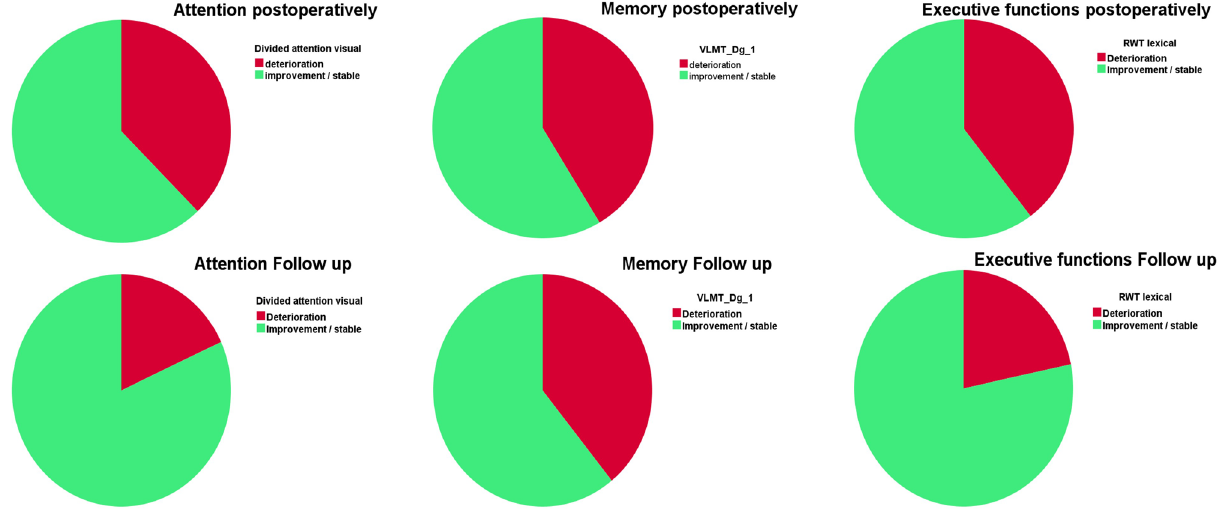
Figure 1. Proportion of patients with improvement/stable condition and deterioration at t 1 and t 2 in selected subtests of the attention (left), memory (middle), and executive functions (right) categories.